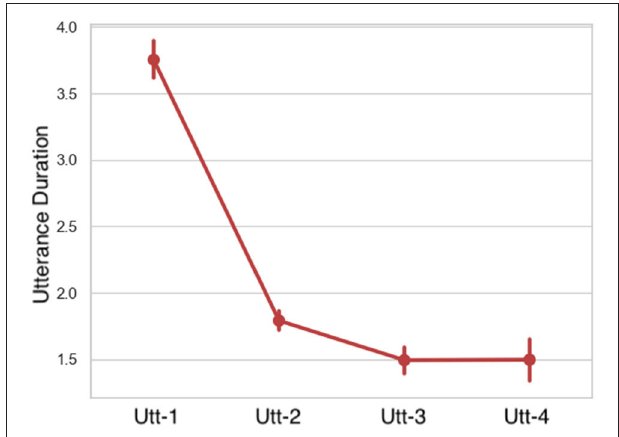
FIGURE 13 | Duration per utterance sequence. Error bars indicate standard error of the means.